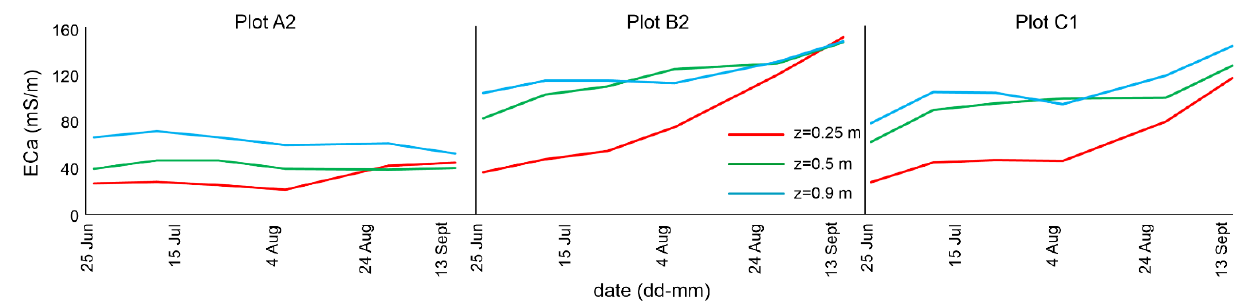
Figure 8. Average ECa value recorded in each plot over time at three different